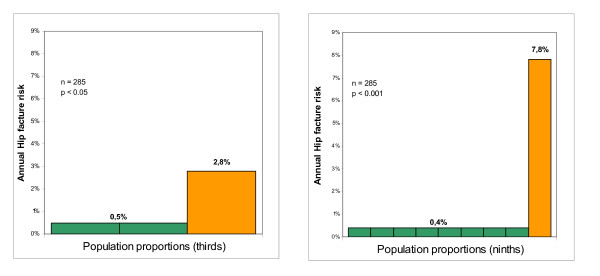
Four risk factors (A) and four risk factors and heel BMD (B). (A) Hip fracture risk 2.8% annually for the 31% women having high FRAMO Index (orange column). Remaining 69% population had risk 0.4% (green column). (B) Hip fracture risk 7.8% annually for the 11% of population having high FRAMO Index + prior fragility fracture + BMD ≤-3.5 SD (orange column). Remaining 89% population had risk 0.4% (green column).